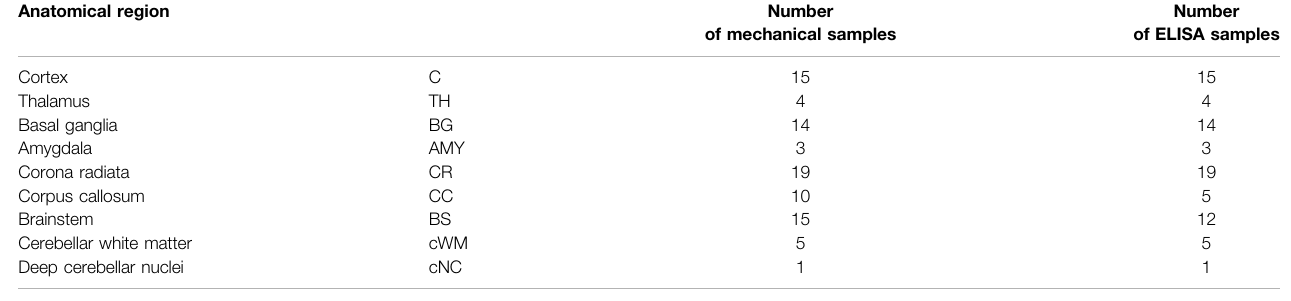
of mechanical samples